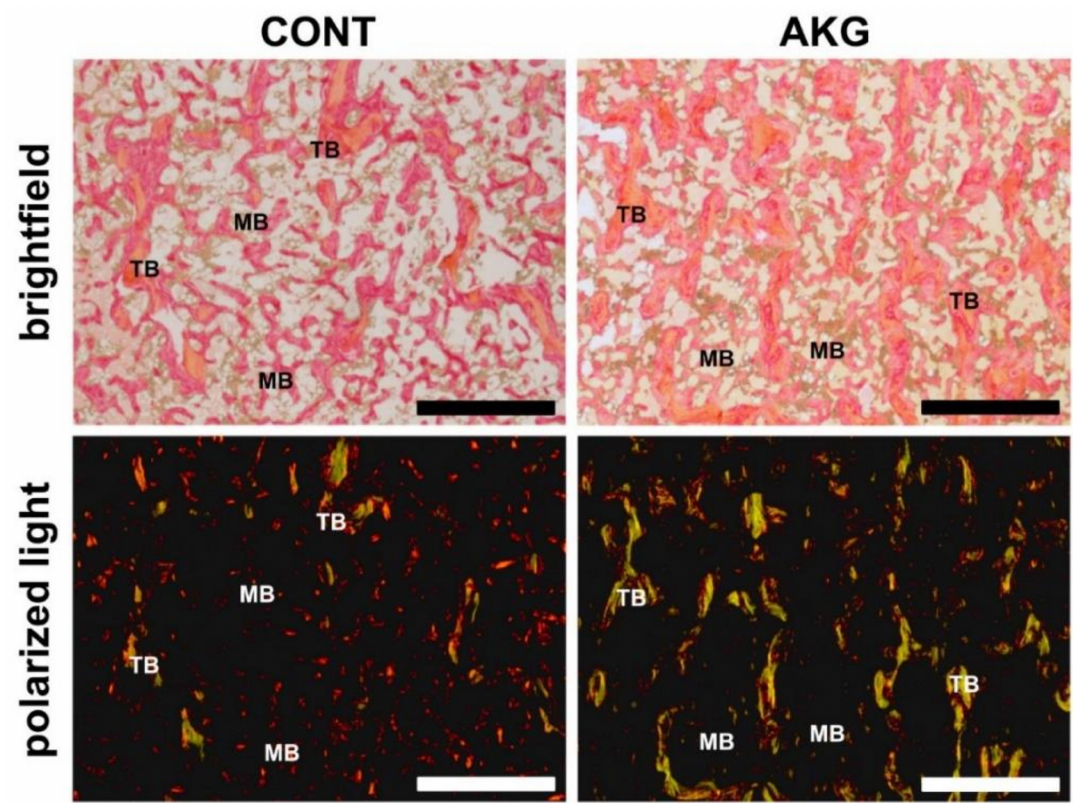
Figure 3. The influence of AKG supplementation during the experimental period (31–60 weeks of age) on bone collagen in laying hens at the age of 60 weeks. Representative images of PSR-stained sections from the tibial trabecular (TB) and medullary (MB) bone of laying hens from the control (CONT) and AKG supplemented (AKG) groups, viewed with conventional brightfield light microscopy and polarized (polarizer and analyzer are “crossed”) light. The large mature collagen fibers are orange or red and the thick ones, including the reticular fibers, are green. All scale bars represent 100 µ m. The analysis of COMP immunostaining in the articular cartilage showed di ff erences in the quantity and distribution of COMP (Figure 5; brown color). Tissues with anti-COMP antibody, control cartilage showed lower accumulation of COMP through the whole thickness of the cartilage, while cartilage from the AKG-supplemented hens showed denser and darker brown staining, indicating higher COMP deposition, especially in the upper zones of the